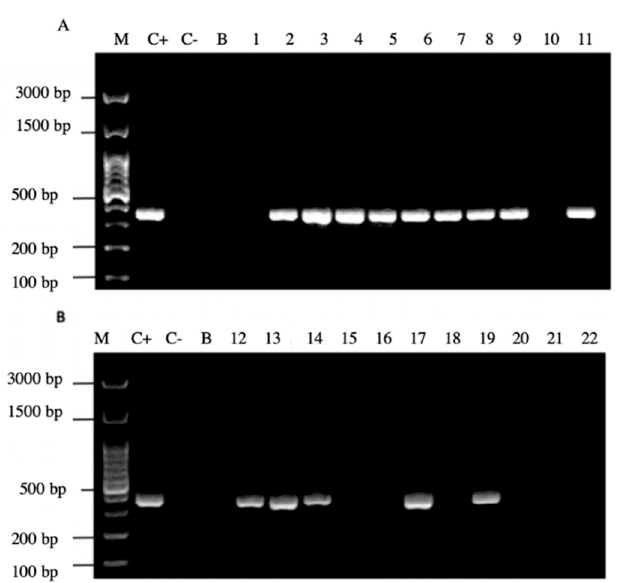
Figure 6. Agarose gel electrophoresis to detect the PCR amplification of the cagA gene of H. pylori (expected size 349 pb) from the DNA of yeast cells from vaginal discharges of term pregnant women. Lane M: molecular weight markers. Lane C+: DNA extracted from H. pylori ATCC 43504 strain (positive control). Lane C − : DNA extracted from C. albicans ATCC 90028 strain (negative control). Lane B: blank (PCR grade water). Lanes 1–11 ( A ) and 12–22 ( B ) DNA extracted from yeasts obtained from the vaginal discharge of term pregnant women.